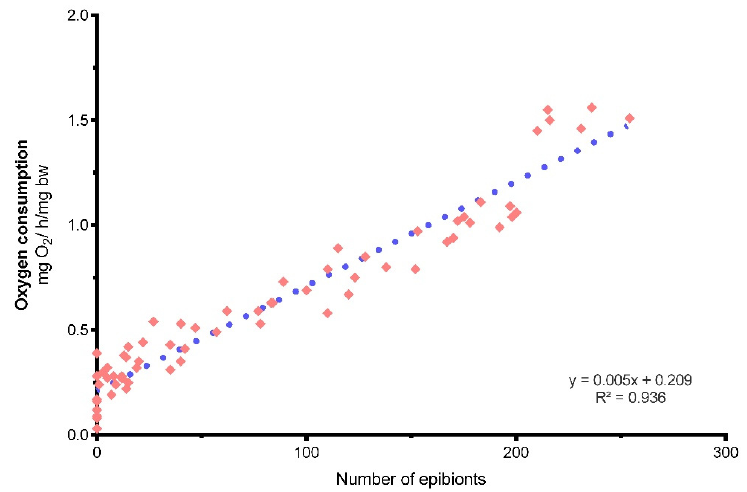
Figure 2. Relation between oxygen consumption and the number of epibionts attached to the gills of crayfish. Table 1. Multiple regression analysis of oxygen consumption vs. number of zooids in gills and crayfish body weight.